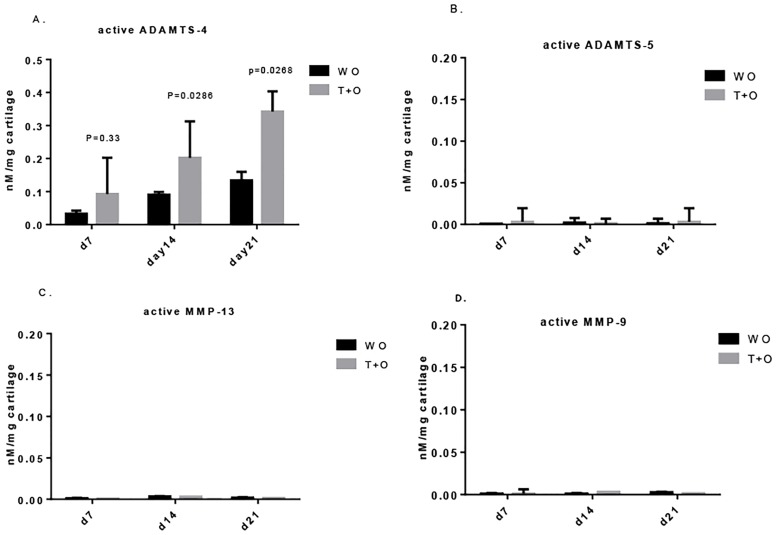
The cartilage extracts by enzyme degradation method from WO group and T+O group were tested for 4 active proteases.Cartilage explants from WO group and T+O group at day 7, 14 and 21 were extracted by using mean of enzymes as previously described [15]. (A) active ADAMTS-4 was accumulated in the WO group. However, stimulation of T+O significantly induced the elevated level of active ADAMTS-4 retained in the matrix. None of (B) active ADAMTS-5, (C) active MMP-13, (D) active MMP-9 was detected in untreated group or treated group. All values were shown as mean±95% confidence intervals (n = 4 in each group). Error bars indicated the upper limit of 95% confidence intervals.